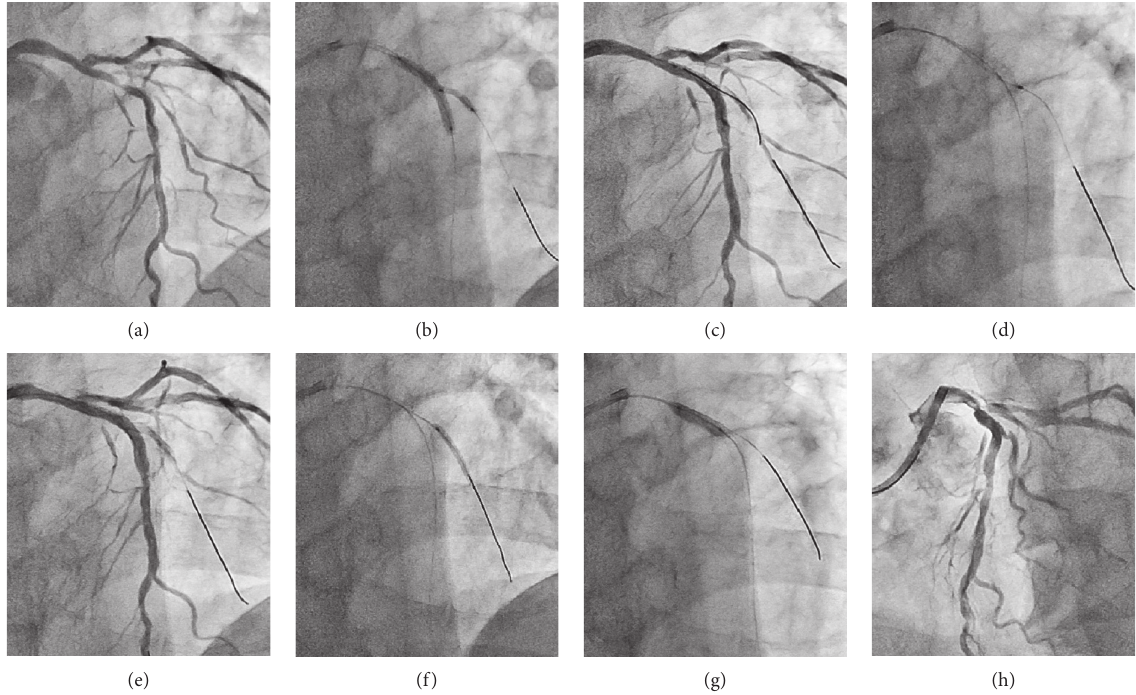
Figure 2: A case of severe dissection in the SB ostium after the modified jailed balloon technique. (a) A control angiographic image of the targeted bifurcated lesion in the mid-LAD artery. (b) DES deployment simultaneously with 2.0 mm jailed balloon inflation in SB. (c) Recrossed guidewire advancement in the dissected lumen of SB. (d) Extrastent balloon dilatation with a 1.5 mm balloon to compress the dissected lumen. (e) Successful guidewire passage in SB with limited blood flow. (f) Vessel fenestration at the lesion of hematoma with a cutting balloon. (g) POTwith a 3.0 mm noncompliant balloon catheter. (h) Final angiography with favorable blood flow both in MV and